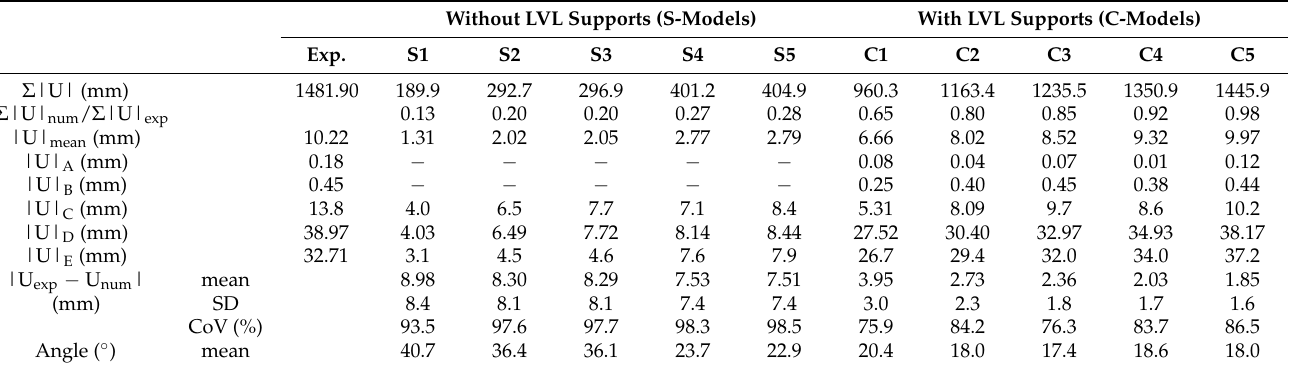
Table 6. Comparison between numerical and experimental displacements. Without LVL Supports (S-Models) With LVL Supports